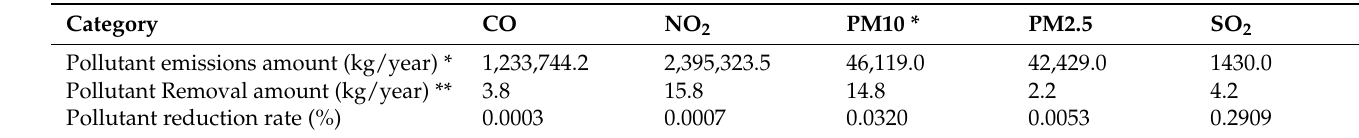
Figure 7. Pollution removal by trees and shrubs — monthly removal. Triangle represent Removal. Table 3. Pollutant reduction rate (based on pollutant emissions from road transport pollutants in Bundang-gu in